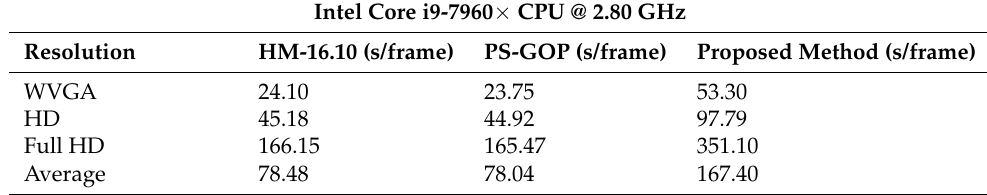
Table 7. Computational